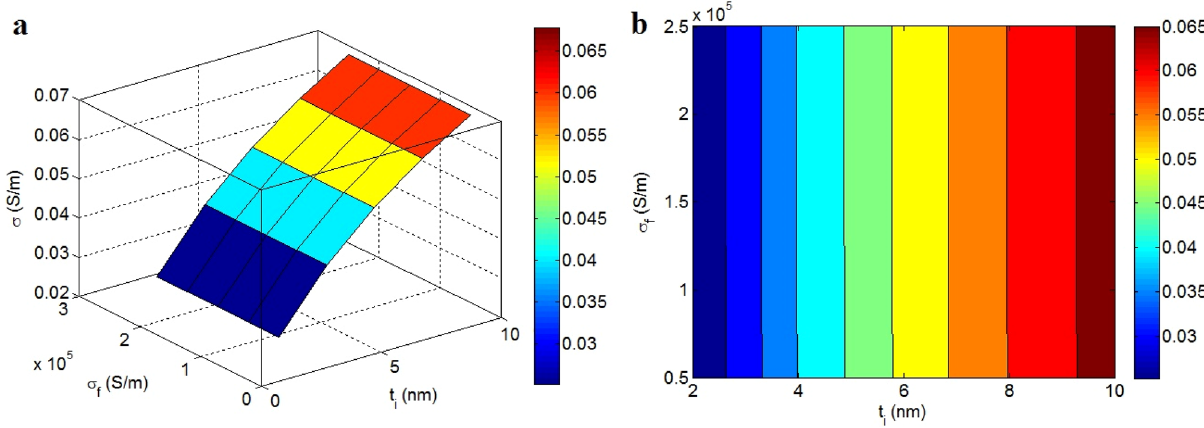
Figure 6. The efficient conductivity by the changes in “t i ” and “σ f ”: ( a ) 3D and ( b ) contour schemes.